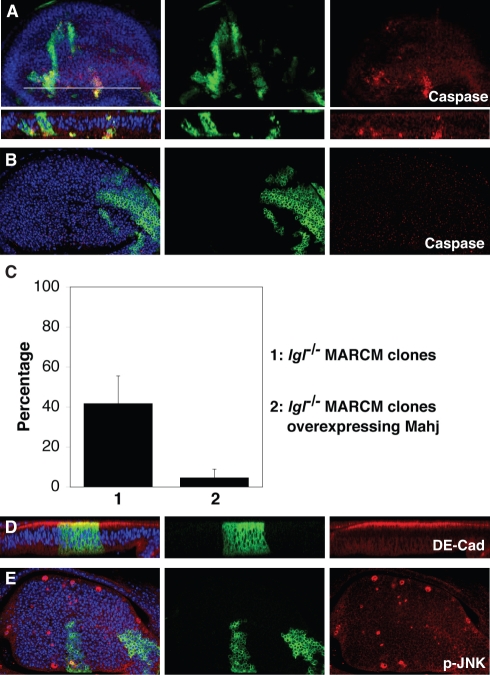
Mahjong acts as a downstream target of Lgl in cell competition and basal cell extrusion.The mosaic analysis with a repressible cell marker (MARCM) system was used to overexpress UAS constructs in either mahj
−/− clones (A) or lgl
−/− clones (B, D, and E). Homozygous mutant clones are marked by the expression of GFP. (A) mahj
−/− MARCM clones overexpressing Lgl at 96 h after clone induction. (B, D, and E) lgl
−/− MARCM clones overexpressing Mahj at 144 h (B and D) or 96 h (E) after clone induction. (C) Quantification of apoptotic cells in the lgl
−/− mosaic wing discs with or without overexpression of Mahj. The percentage of apoptosis occurring in lgl
−/− cells on the boundary with wild-type cells was examined. The results represent means±SD (n = 13 discs, *p<0.001). (D) A transverse section. Anti-cleaved Caspase-3 (A and B), anti-DE-Cadherin (D), and anti-phospho JNK (E) antibodies were used for immunostaining. (A, B, D, and E) Nuclei were stained with DAPI (blue).